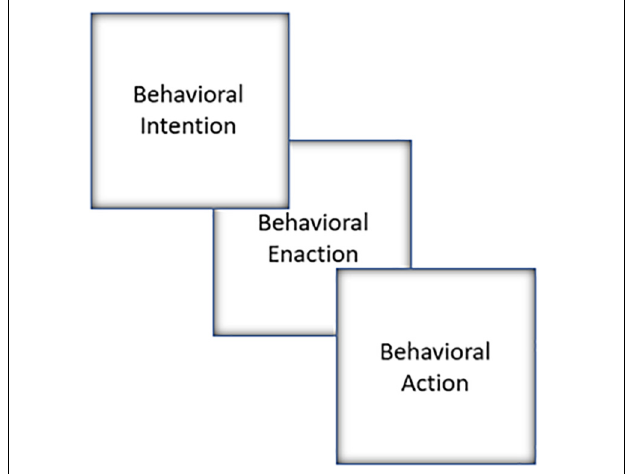
FIGURE 3 | Identity Behavior Theory. Conceptual representation of Simons’ Identity Behavior